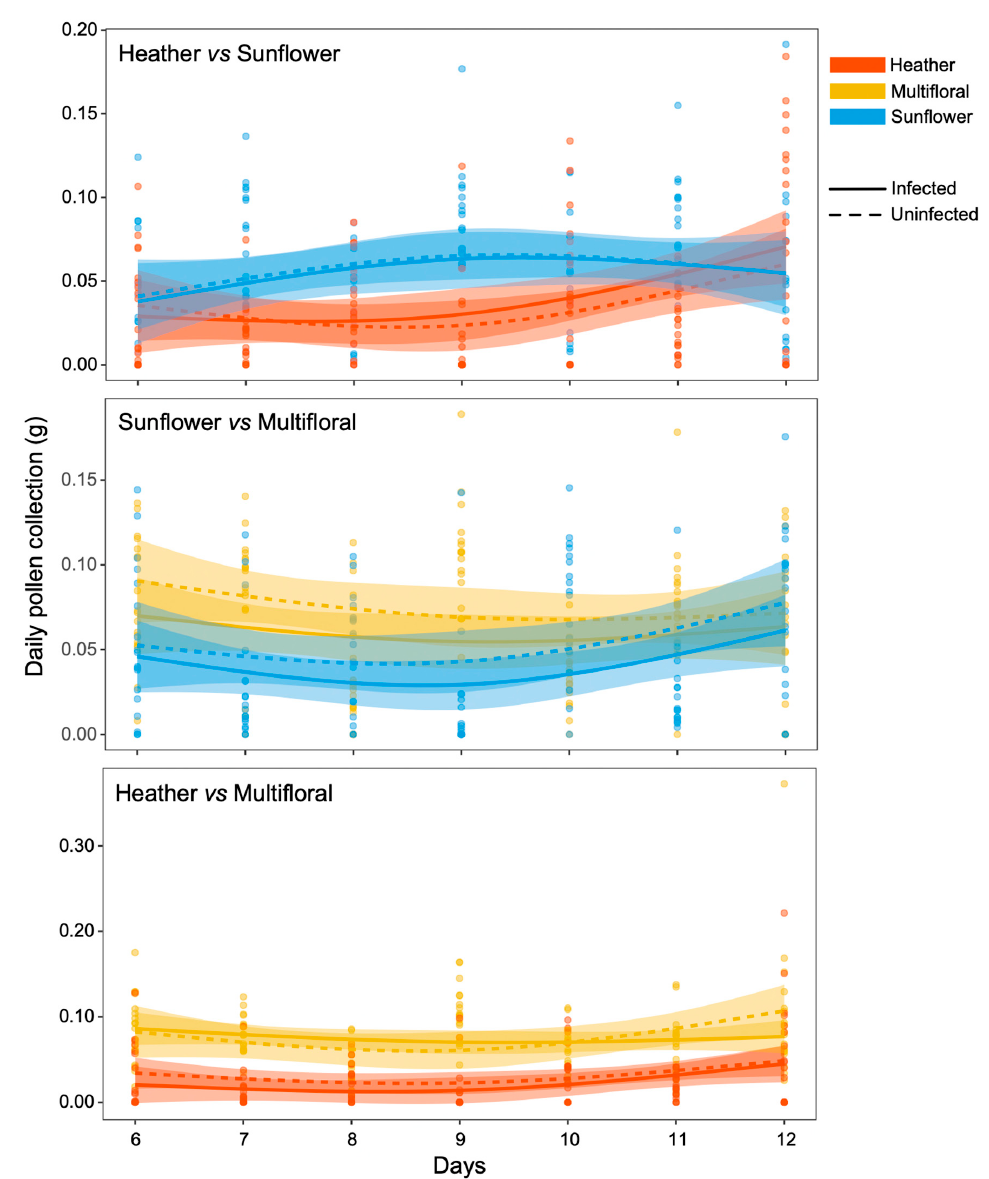
Figure 7. Amount of daily collected pollen (g, standardised by total mass of Bombus terrestris workers) in microcolonies being offered a choice between heather or sunflower pollen, sunflower or multifloral pollen, and heather or multifloral pollen. Generalised additive mixed effect models (GAMMs) were used to fit smoothers to the data showing mean trends ( ± 95% confidence intervals) over time. Each dot represents one data point (i.e., standardised amount of collected pollen per day for each microcolony).